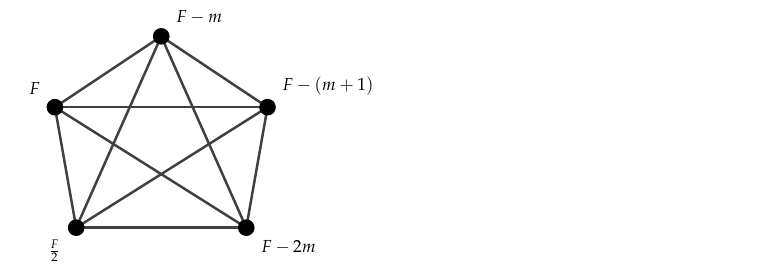
Figure 10. Minimum possible clique for the case m ≥ 2 q + 4, e = m − 2 q and q ≥